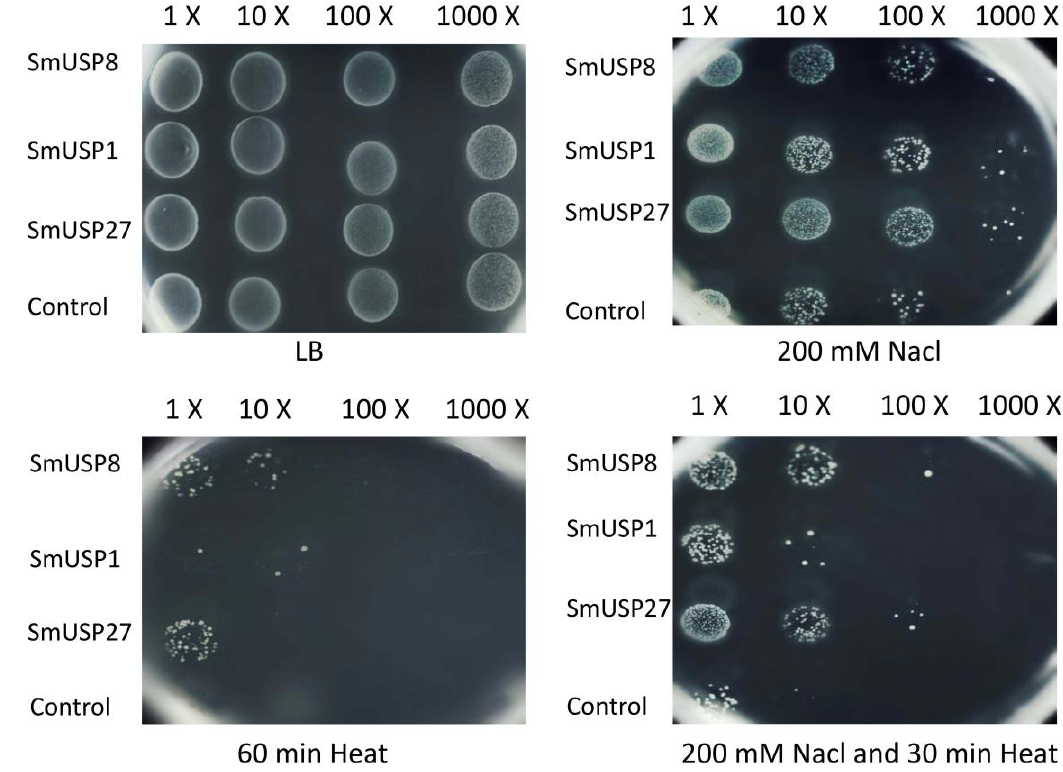
Figure 8. Overexpession of SmUSP1 , 8 , 27 in E. coli enhanced the tolerance to different stresses by spot assay. Each sample was diluted 10-fold, 100-fold, and 1000-fold and spotted onto Luria-Bertani (LB) plates to assess tolerance to various stress treatments. LB represents E. coli BL21 strains transformed plasmids pET28a– SmUSPs and the empty vector pET28a were spotted onto LB solid media; 200 mM NaCl represents those strains were spotted onto LB solid media containing 200 mM NaCl; 60 min Heat represents those strains were exposed to 50 ◦ C for 60 min before 7- µ L aliquots were spotted on LB media; 200 mM NaCl and 30 min Heat represents those strains exposed to 50 ◦ C for 30 min before 7- µ L aliquots were spotted on LB media containing 200 mM NaCl.